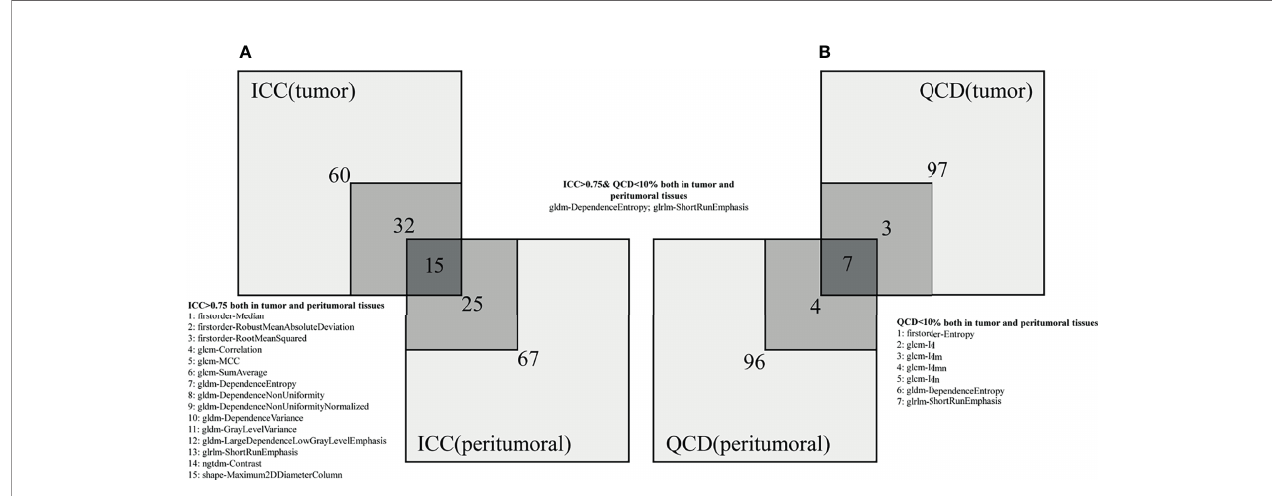
FIGURE 4 | Numbers of radiomic features not affected by intra-/inter-observer MR delineations. (A, B) represent the ICC and QCD,